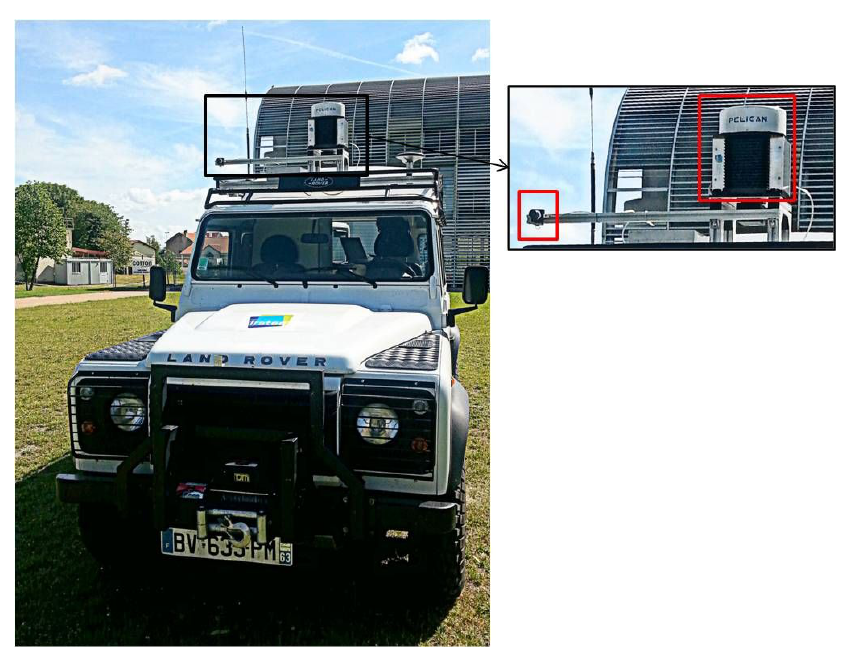
Figure 17. Radar and camera system. The image to the right presents the zoom in of the sensors system (the radar to the right and the camera to the